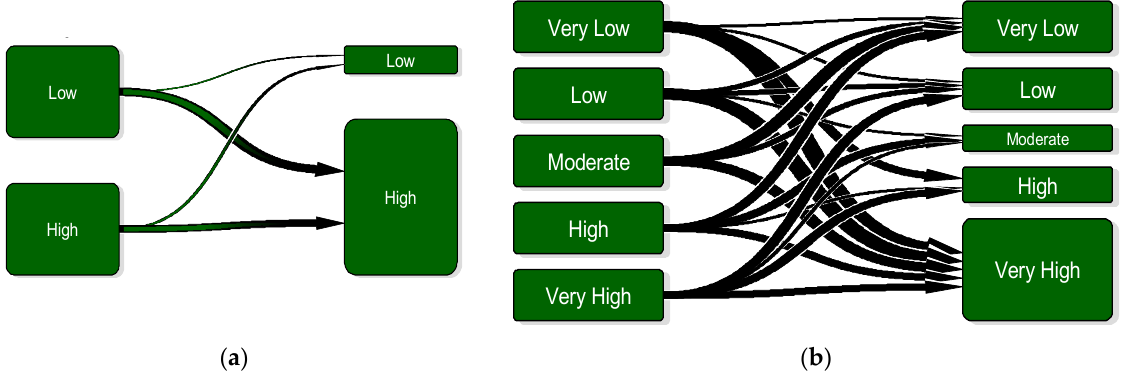
Figure 8. ( a ) Mosquito population transition network with two states and ( b ), mosquito population transition network having five states. Thicker arrows indicate greater probability of transitions.